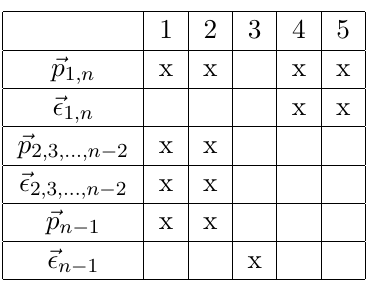
Table 2 . Kinematic con(cid:12)guration of momenta and polarizations of BI 6 de(cid:12)ning the 3d dimensional reduction of mDBI 4 . The 3-direction will be T-dualized, mapping the polarization of the photon labeled n (cid:0) 1 to a brane